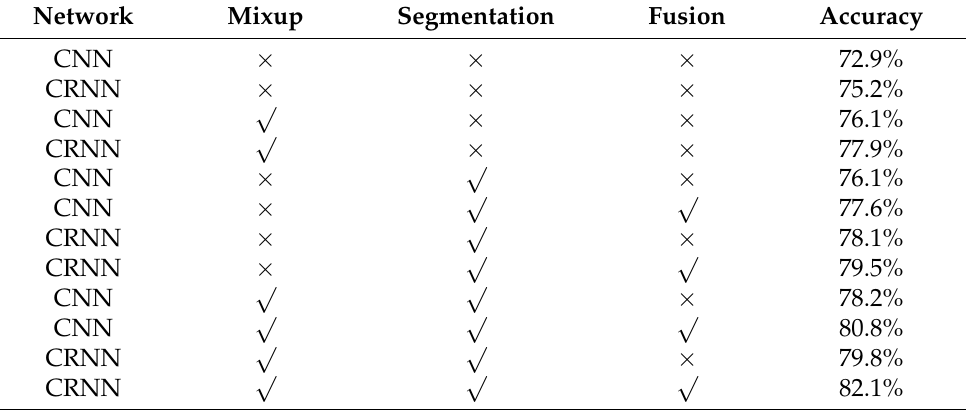
Table 10. Comparison for different combinations of mixup, CNN, RNN, segmentation, and score level fusion. When using segmentation, the N ss , { f i } and { ω i } are set as 4, {3, 6, 10} and {0.4, 0.2, 0.2, 0.2},